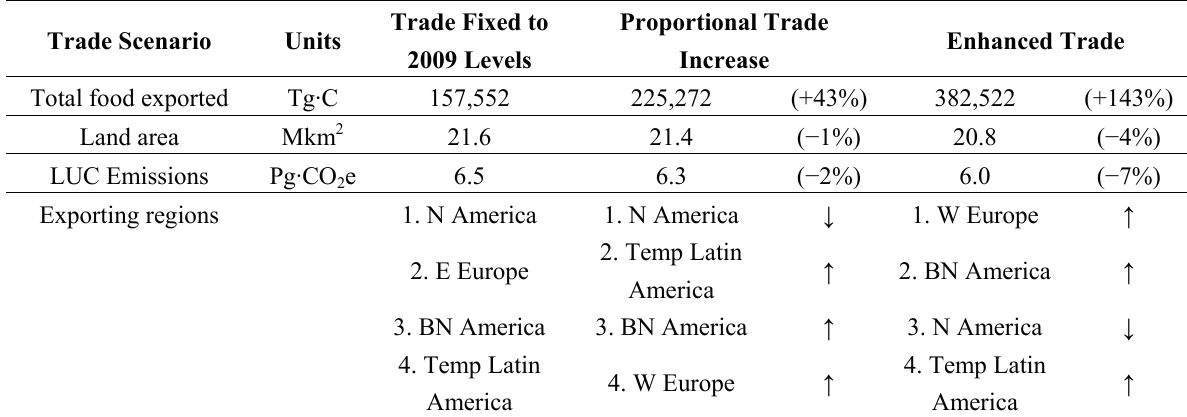
Table 6. A comparison between different trade scenarios, under the A1 climate change impacts in 2050. With increases in trade, agricultural impacts decline. The lower part of the table shows changes in export and imports of the main exporting and importing regions, with the arrows showing increases and decreases in the respective